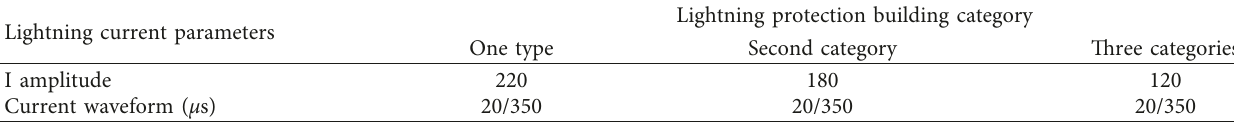
Table 1: Lightning current amplitude of the first lightning